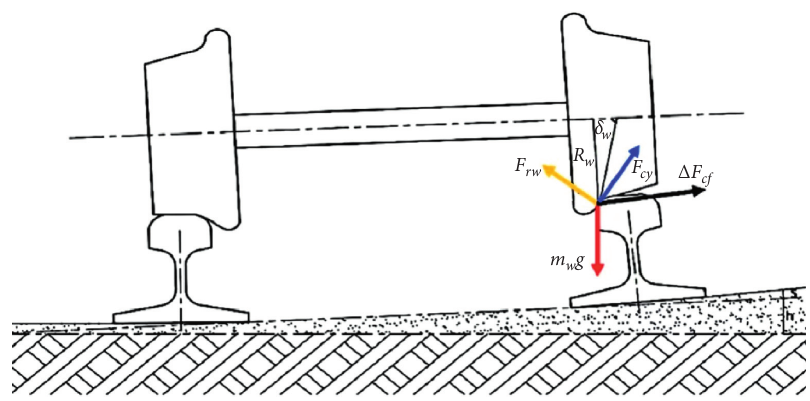
Figure 1: Wheel-rail contact